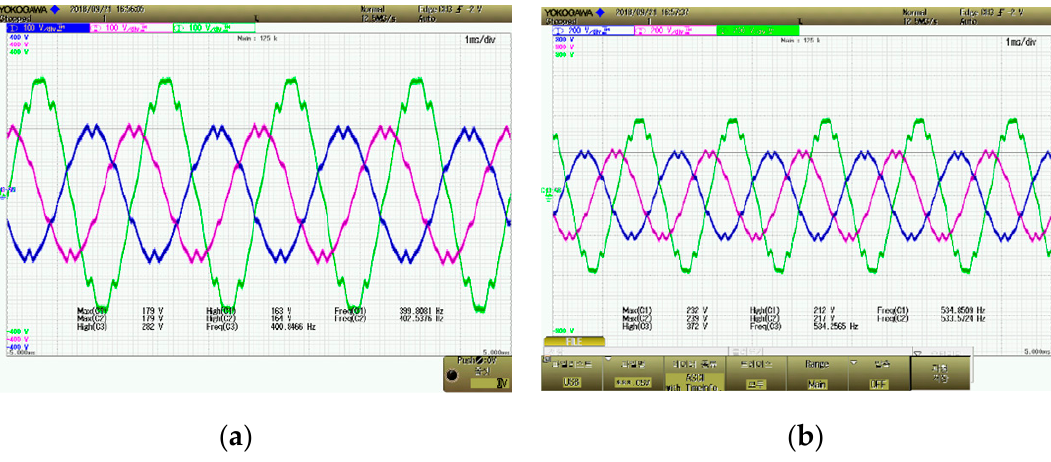
/ purple / green: U / V / U to V: ( a ) 6000 r / min and ( b ) 8000 r / Figure 15. Measured back-EMF, blue/purple/green: U/V/U to V: ( a ) 6000 r/min and ( b ) 8000 r/min. Figure 15. Measured back-EMF, blue